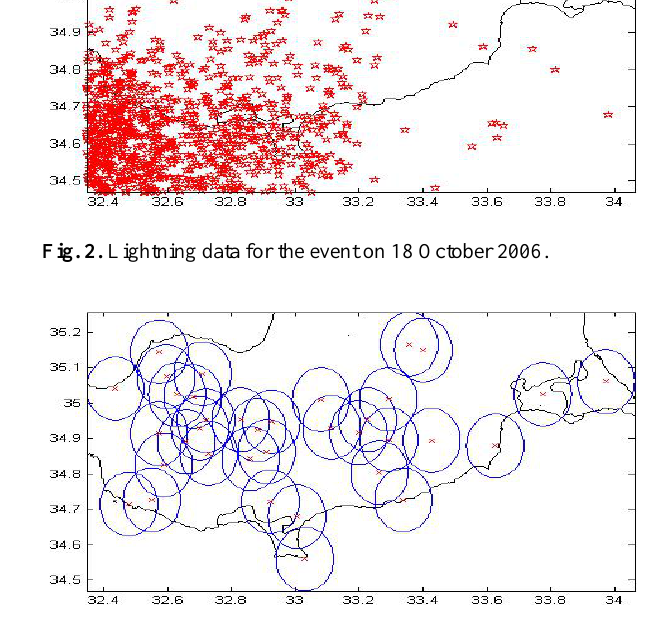
Fig. 3. Rainfall stations with precipitation of more than 5mm, concerning the event on 18/10/2006; the radius defining the area around each station is 10km.